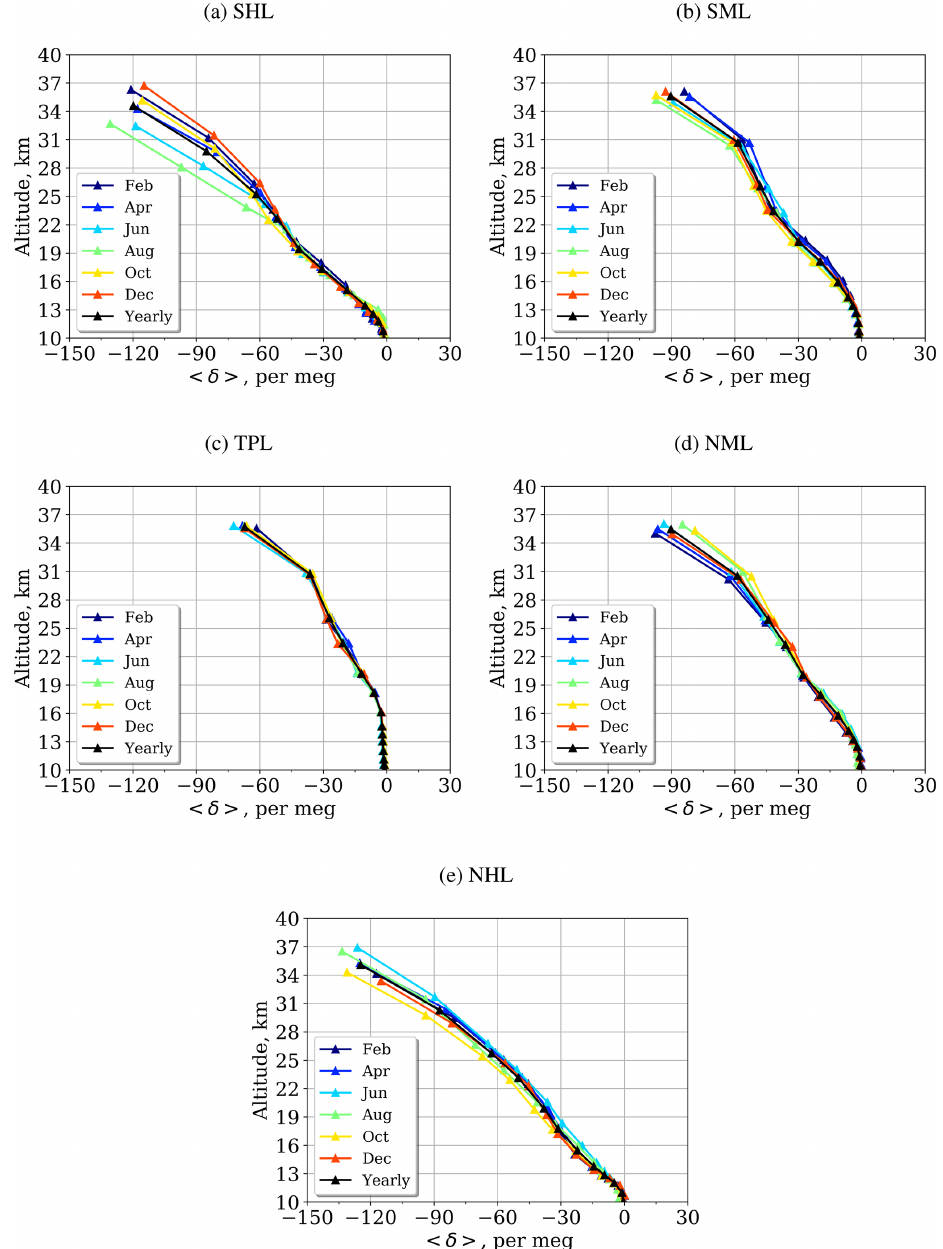
Figure 4. Profiles of (cid:104) δ (cid:105) calculated by the model for February, April, June, August, October, December, and yearly mean averaged for 2000–2015 over the five latitudinal bands shown in Table